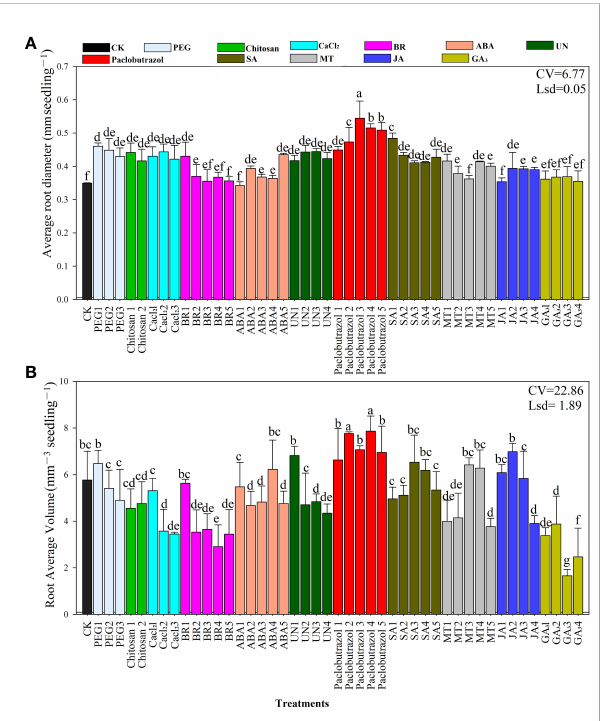
FIGURE 2 Responses of average root diameter (A) and root volume (B) to the different seed priming treatments under chilling stress. CV, coef fi cient of variation; Lsd, least signi fi cant difference. Different lowercase letters indicate signi fi cant differences (P< 0.05). Bar shows standard error. See Table 1 for treatment details.